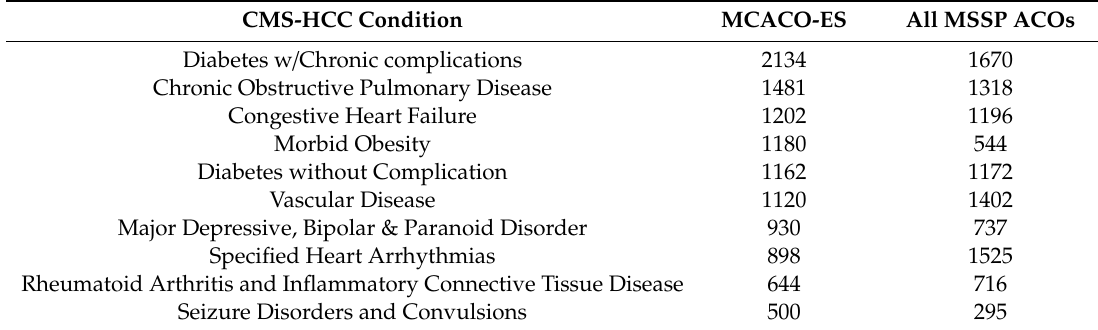
Table 3. Frequencies and Rates per 10,000 Beneficiaries by Disease Group (CMS-HCC) for Assigned